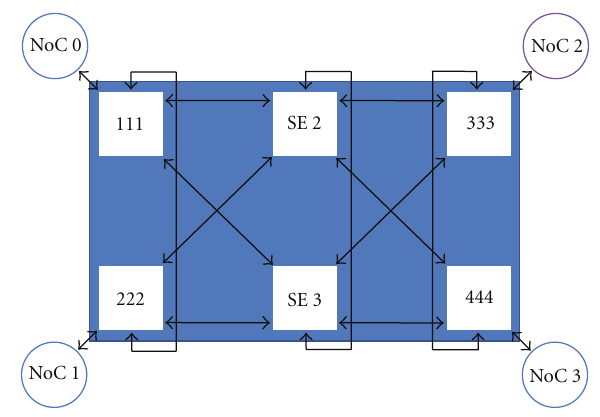
Figure 16: The simulation state of NiP-HXN model at first step of best case.